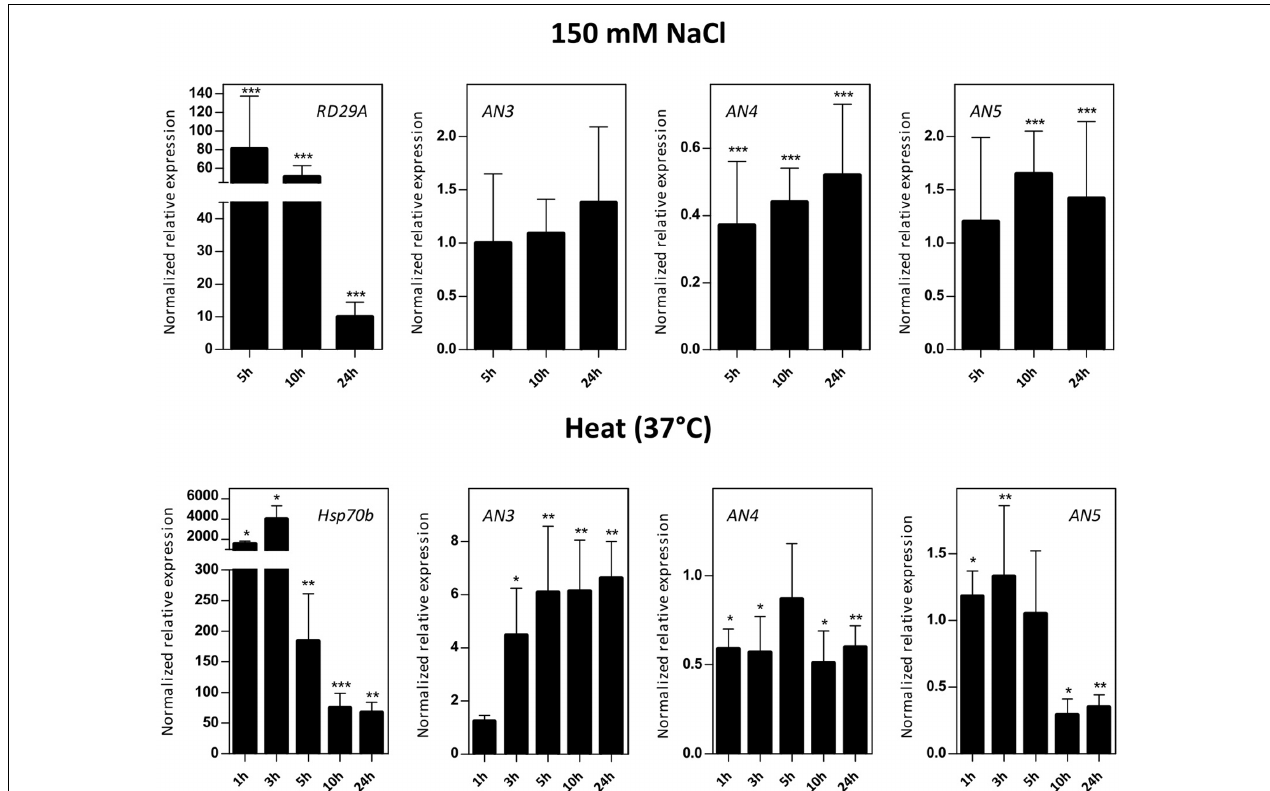
FIGURE 5 | Normalized relative expression for ArathNictaba genes after salt and heat stress. The normalized transcript levels are the result of two or four independent biological replicates ( N = 2 for heat stress, N = 4 for salt stress). They are presented relatively to the ArathNictaba expression level determined in the mock treated plantlets. Bars represent the mean ± SE normalized relative expression and asterisks indicate statistically significant differences to the expression level of ArathNictaba in mock treated plantlets ( ∗ p ≤ 0.05, ∗∗ p ≤ 0.01, ∗∗∗ p ≤ 0.001; REST analysis). The normalized relative expression levels of the control genes for each stress are presented in the left